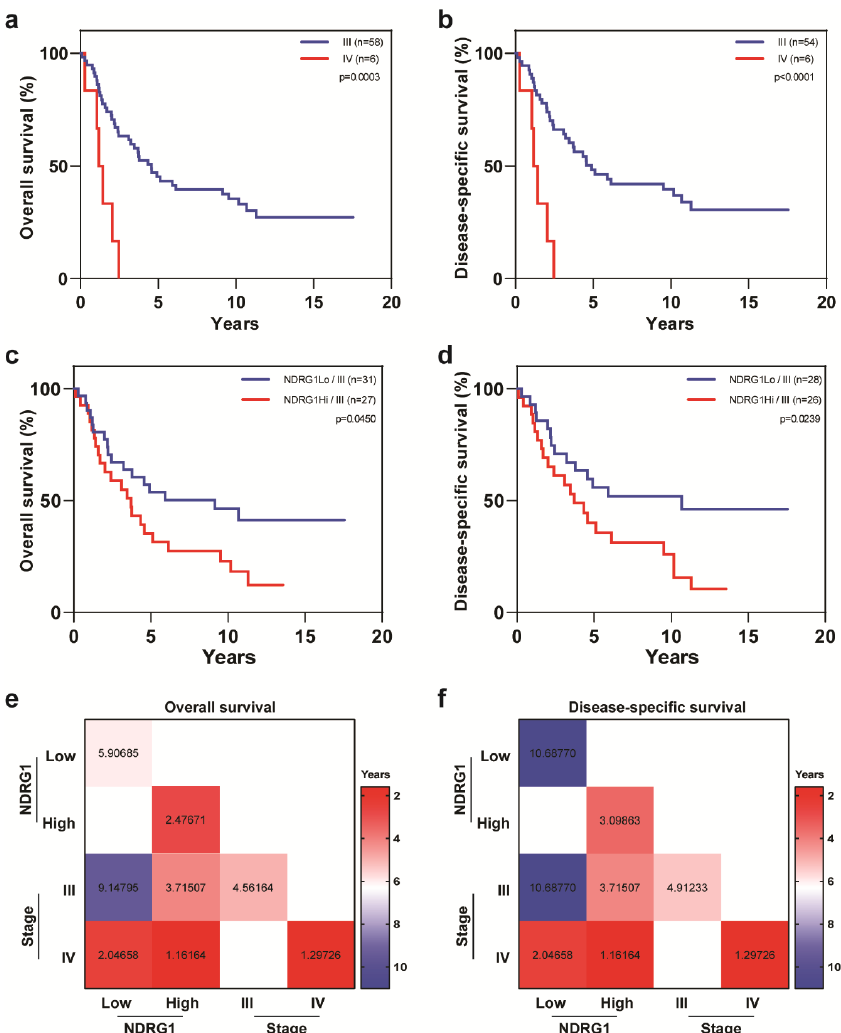
Figure 4. Overall survival and disease-specific survival in patients with IBC stratified by disease stage and NDRG1 expression. Patients with stage III IBC had better ( a ) overall survival and ( b ) disease-specific survival than did patients with stage IV IBC. ( c , d ) Patients with stage III IBC stratified by NDRG1 expression in terms of overall survival and disease-specific survival. Log-rank tests were